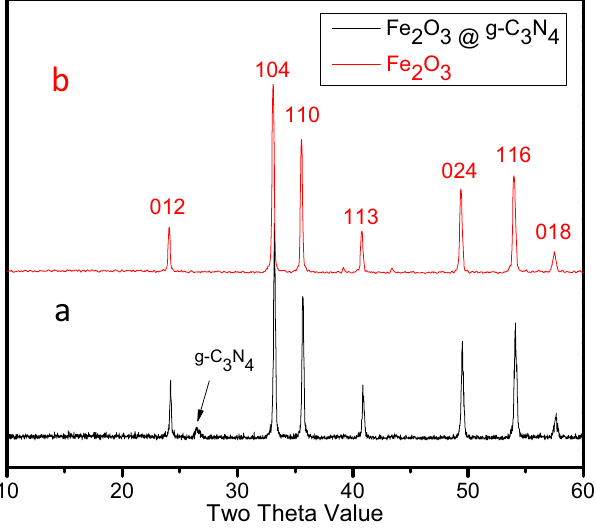
Figure 1. XRD patterns of ( a ) mesoporous α -Fe 2 O 3 @g-C 3 N 4 -NCs and ( b ) α -Fe 2 O 3